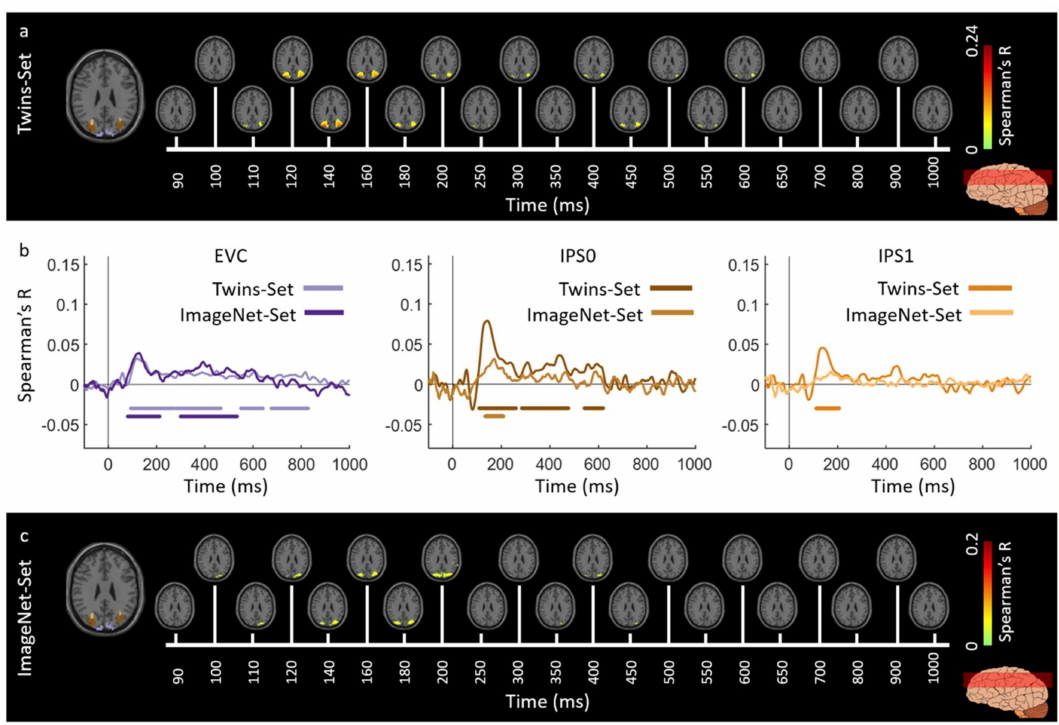
Figure 7. Spatiotemporal neural dynamics of vision in dorsal stream: ( a ) An axial slice encompassing early visual cortex (EVC) and dorsal ROIs, inferior parietal sulcus (IPS0 and IPS1). The significant correlation maps for Twins-set (Experiment 1) in this axial slice depicted over time (n = 15, cluster-definition threshold P < 0.001, cluster threshold P < 0.01); ( b ) The correlation time series are computed based on spatially restricted searchlight voxel-wise fusion analysis (see Methods). The depicted curves from left to right compare these time series in EVC and dorsal ROIs, IPS0 and IPS1 for Twins-set (Experiment 1) and ImageNet-set (Experiment 2). Significant time points depicted with color coded lines below the graphs are determined with sign-permutation tests (n = 15; P < 0.01 cluster-definition threshold, P < 0.01 cluster threshold); ( c ) The significant correlation maps for ImageNet-set (Experiment 2) in the same axial slice as (a) depicted over time (n = 15, cluster-definition threshold P < 0.001, cluster threshold P <